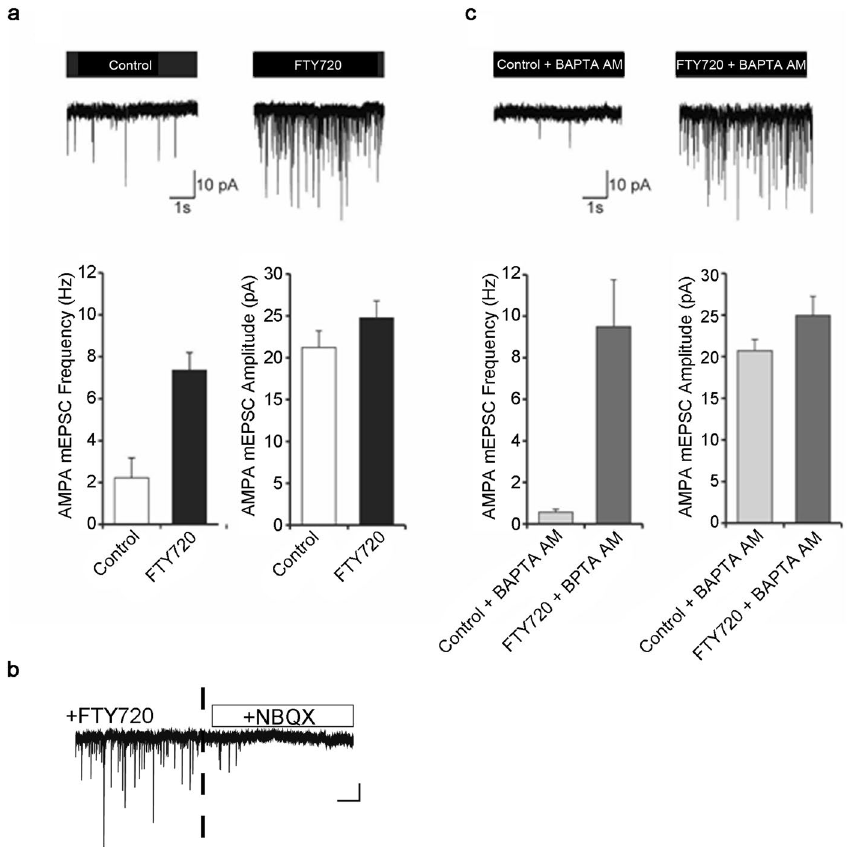
Figure 5. FTY720 augments spontaneous mEPSC activity in rat hippocampal neuronal cultures. ( a ) Representative traces of mEPSCs for control neurons and neurons treated with 10 µ M FTY720. A three-fold increase in synaptic mEPSC frequency was detected after application of FTY720 (p < 0.0001, t-test), n = 6 for control, n = 8 for FTY720. Only a small insignificant increase in mEPSC amplitudes was observed after FTY720 application (control 21.2 ± 2; FTY720 24.8 ± 2). ( b ) The stimulating effect of FTY720 can be blocked by 10 µ M NBQX, a specific antagonist of AMPA receptors. ( c ) Cell-permeable calcium chelator, BAPTA-AM does not block the stimulating effect of FTY720 on neuronal mEPSC frequency but reduces basal mEPSCs frequency. Application of FTY720 significantly increased mEPSC frequency in neurons pre-treated with BAPTA-AM (p < 0.0001, t-test), n = 5 for control, n = 9 for FTY720. 20% increase in mEPSC amplitudes was observed in the presence of BAPTA-AM (control 20.7 ± 1; FTY720 24.9 ±